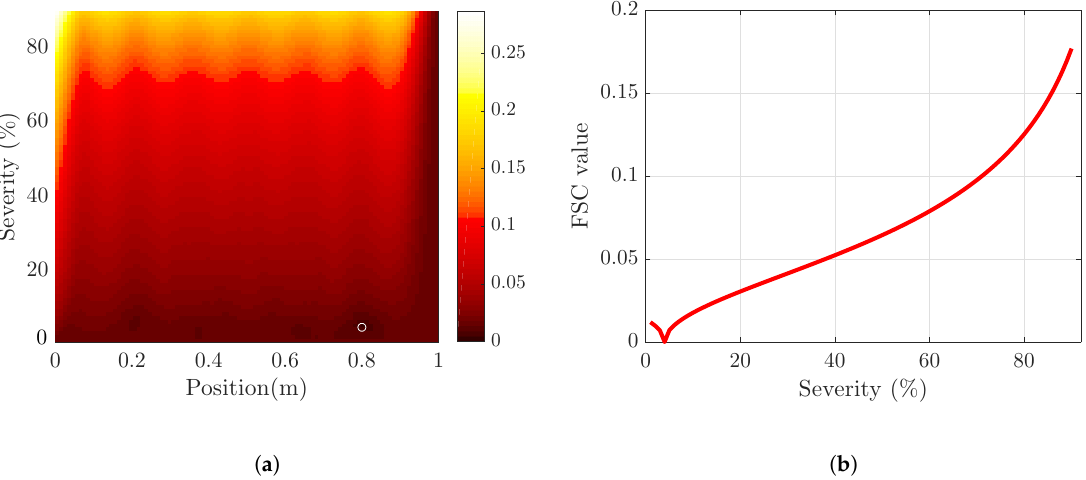
Figure 9. FSC as a function of tested position and severity, where ( a ) the white circle indicates 4% severity and 0.80 m position identified by the algorithm ( b ) slice view of 4% estimated damage.